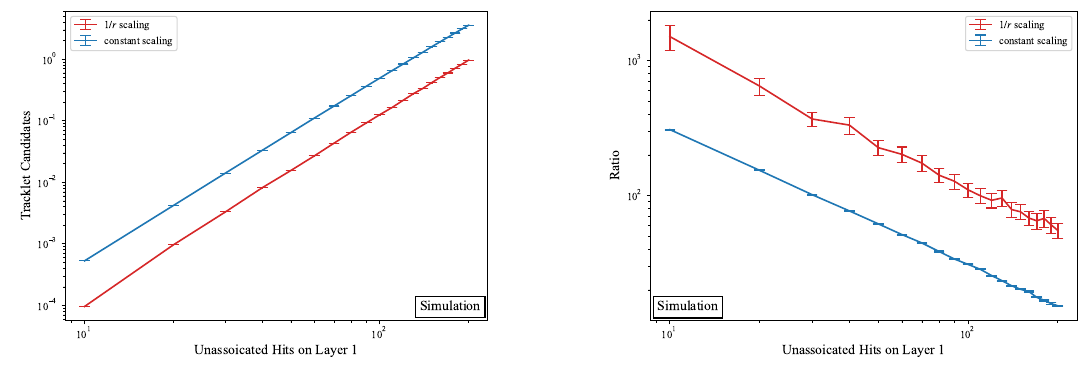
Figure 8 . Left: the number of 3-layer tracklet candidates, up to an unknown normalization factor, as a function of the number of unassociated hits on the innermost pixel layer. Right: the enhance- ment in the number of tracklet candidates in going from a 4-layer search to a 3-layer search. Results were obtained from the simulation described in the main text, for a constant and 1 /r scaling of the number of hits on the first pixel layer, in going to outer detector layers. The arbitrary normalization in the left plot encodes fine details of pile-up distribution, detector layout and tracklet reconstruc- tion that are not included in our simulation. We expect these unknowns to fall out in the